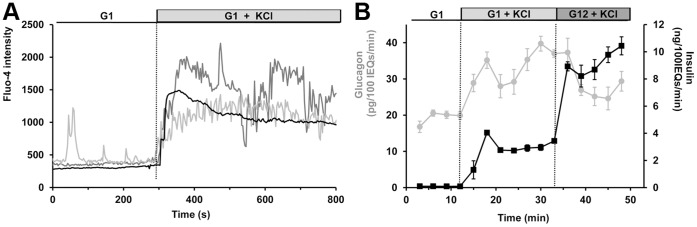
Effects of KCl on islet [Ca2+]i and hormone secretion.Gray and black traces represent α- and β-cells, respectively. A, intracellular calcium responses from an islet perifused at 1 mM followed by addition of 20 mM KCl. 2 α-cells from the same islet are presented. Fluo-4 intensity is expressed in arbitrary units. The figure is representative of 12 α-cells from 4 islets harvested from 3 mice. B, glucagon and insulin were measured for 9 minutes at 1 mM glucose (G1), and KCl was then perifused at 20 mM for 20 minutes, and glucose was added for 15 minutes at 12 mM (G12). Experiment was repeated 4 times, 600 islets from 8 mice were used. Error bars represent the standard error of the mean.